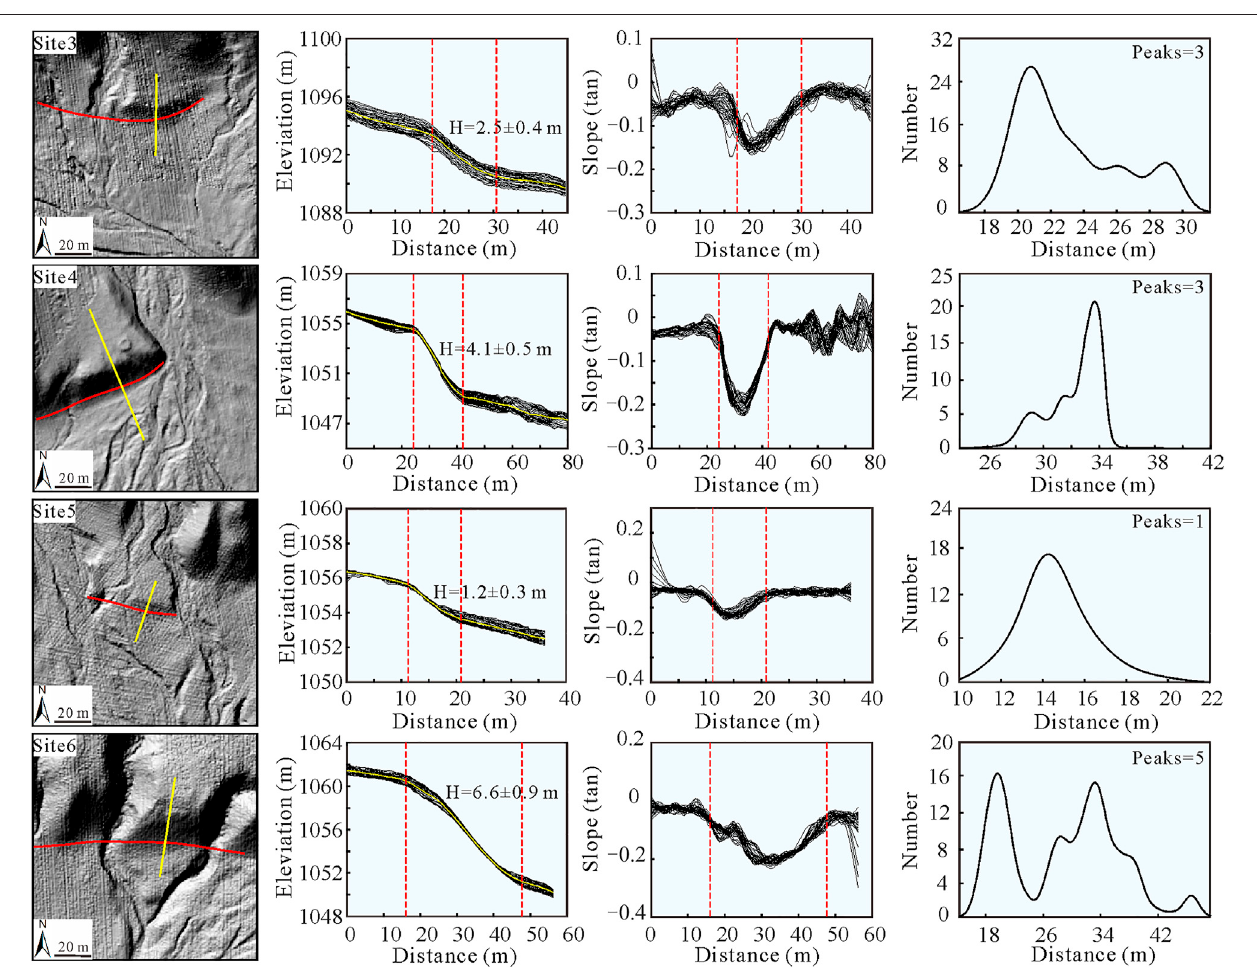
FIGURE11| Identi fi cation ofslopebreaksinthescarppro fi les at foursites on theGongmiaozi-Heshunzhuangsegment. The fi rstcolumn displays the LiDAR-DEM at each site, and the red and yellow lines represent the fault trace and extracted topographic pro fi le, respectively. In the second column, the black lines indicate the extractedswath topographicpro fi les (40 topographicpro fi les at aninterval of 0.5 m), and the yellow line denotes theaveraged topographicpro fi le,whilethered dashed linesmarkthescarprange.Inthethirdcolumn,theblacklinesindicatethecalculatedswathslopepro fi les.Inthefourthcolumn,theblacklinedenotestheprobability density distribution of the positions of all searched slope breaks in the swath slope pro fi les, and the number of peaks represent the number of slope breaks, that is the number of surface-rupturing events.